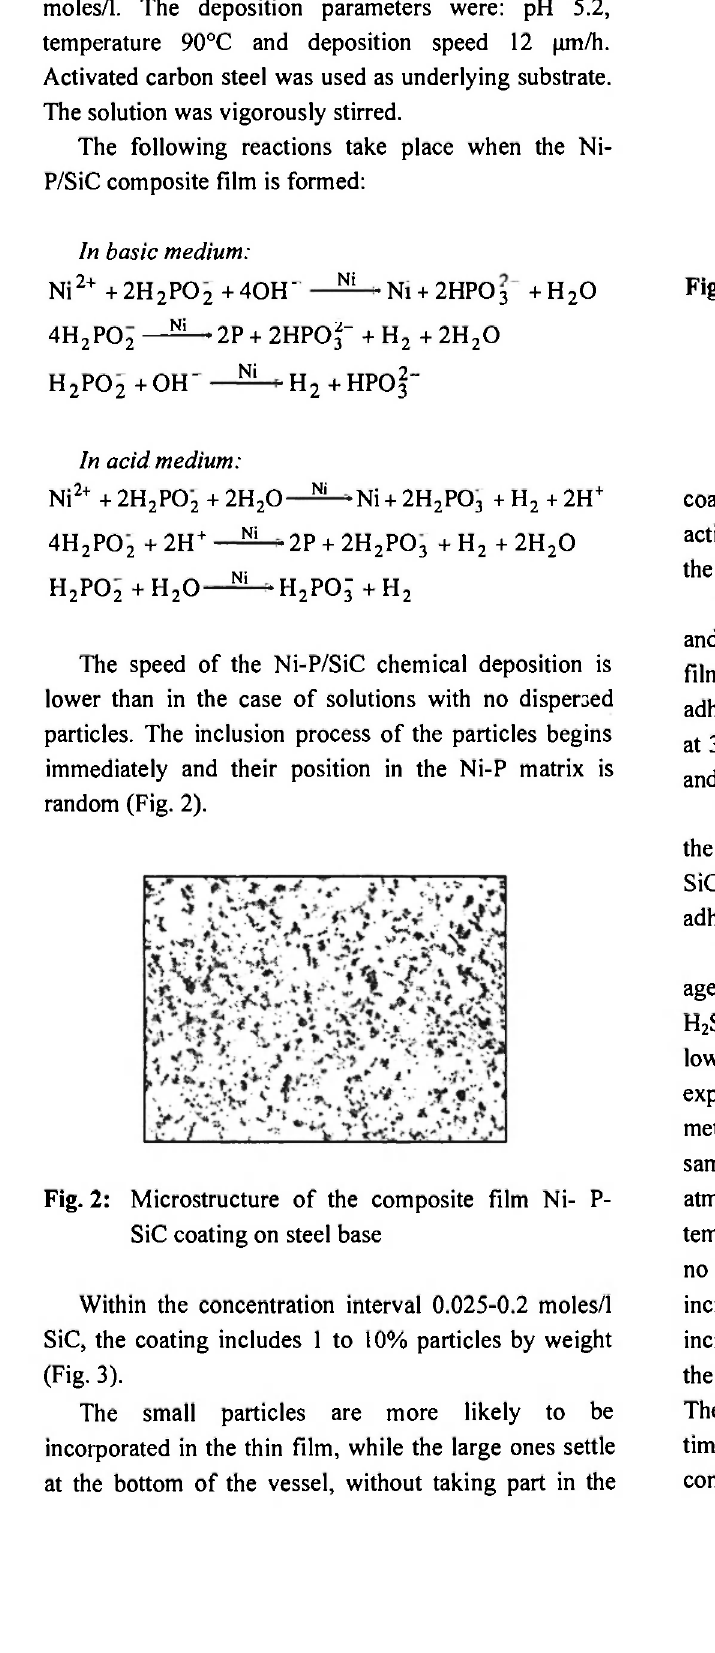
Fig. 3: Dependence of the silicon carbide weight percentage in Ni-P/SiC on the SiC concentration in solution, with citrate- hypophosphite